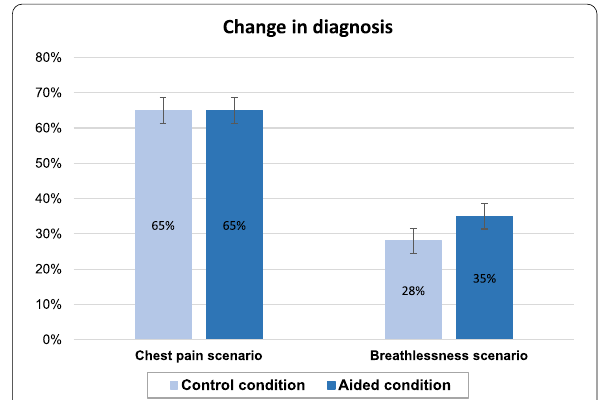
Fig. 2 Frequency of diagnostic changes by condition and